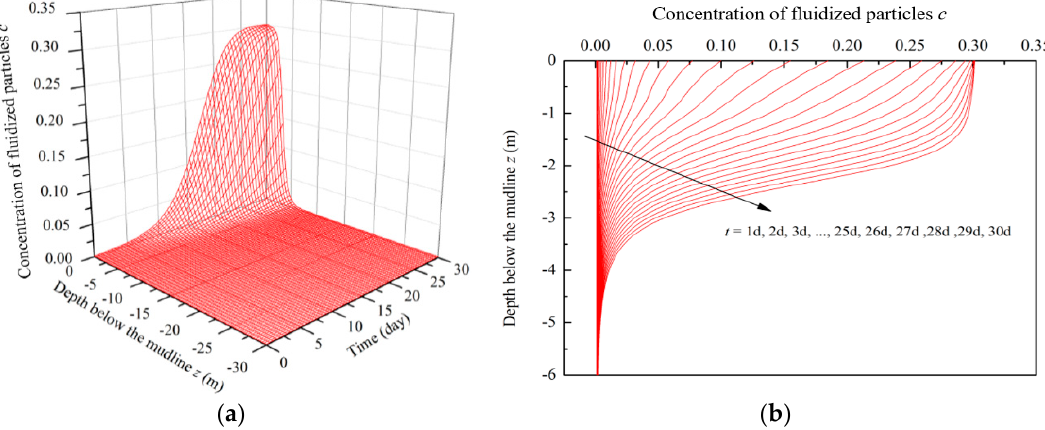
Figure 6. Variations of the concentration of moving particles with the increase of wave acting time: ( a ) Diagram of three-dimensions; ( b ) diagram of two-dimensions.